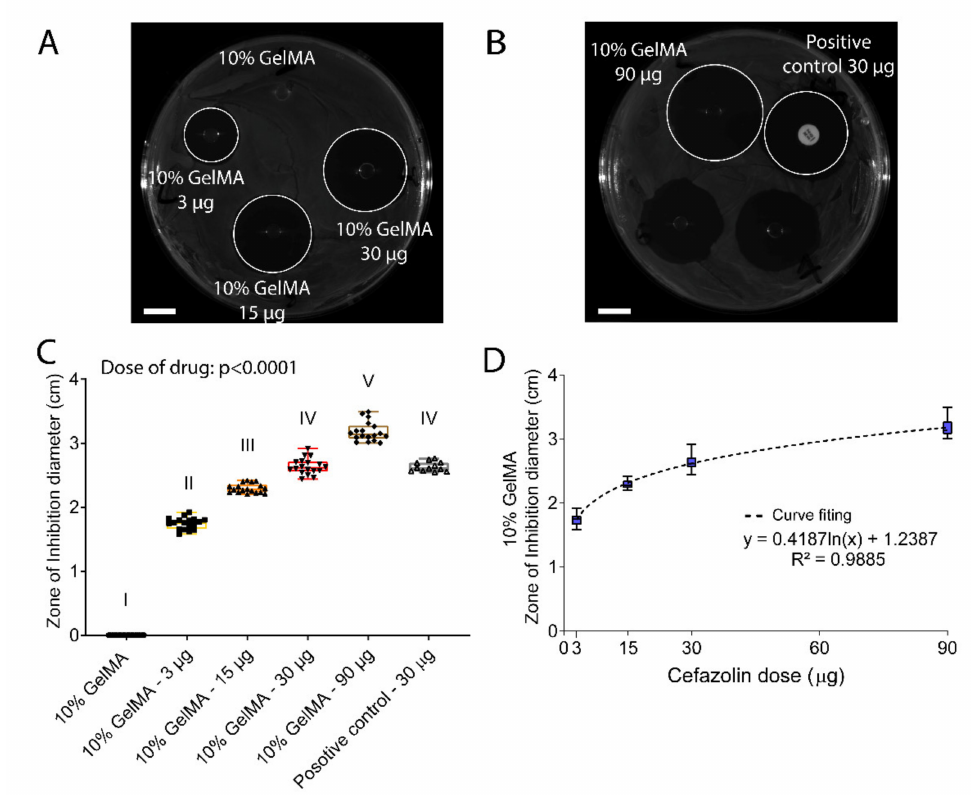
Figure 8. In vitro evaluation of 10% GelMA-DDS efficacy against S. aureus in a zone of inhibition assay. S. aureus was spread on Petri dishes containing Mueller-Hinton agar, then samples were placed on the culture plate and left incubating at 37 ◦ C overnight. ( A , B ) Representative pictures of Petrie dishes at the end of the assay. Scale bar = 1 cm. ( C ) Zone of inhibition in cm. Results are shown as box plots. Groups with no statistical difference are marked with the same roman numeral. ( D ) Non-linear regression for GelMA 10% versus cefazolin doses. The experiment was performed three times with n = 6 each